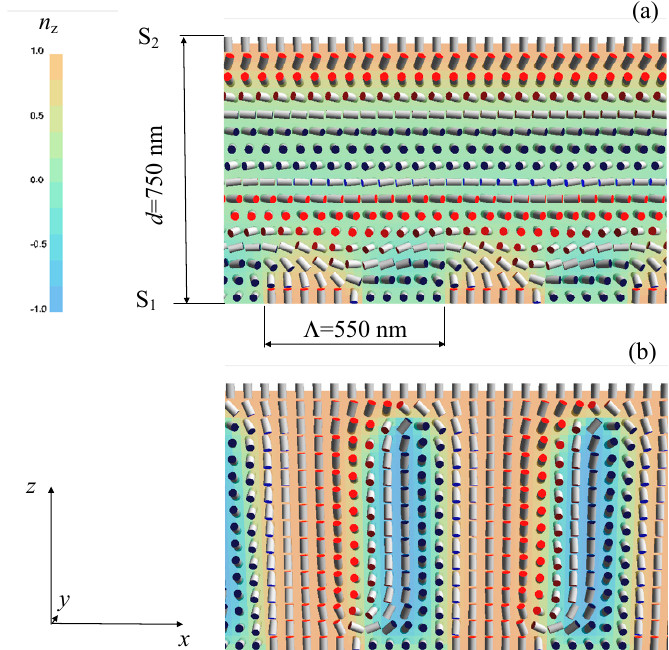
Figure 4. Initial at U = 0 V ( a ) and DLH at U = 4 V ( b ) (during the scan-down the voltage half-cycle) director field distributions in a CLC layer (thickness d = 750 nm). The S 1 alignment surface provides the periodic (planar/homeotropic) anchoring conditions with the spatial period Λ = 550 nm. The S 1 and S 2 alignment surfaces provide the infinite anchoring energy. The color scale is given for the n z component of the LC director. The parameters of the CLC material used in the simulations are as follows: natural pitch p 0 = 260 nm; elastic constants K 1 = 11 pN, K 2 = 8 pN and K 3 = 17 pN; low frequency principal dielectric constants ε ⊥ = 6, ε || = 20.